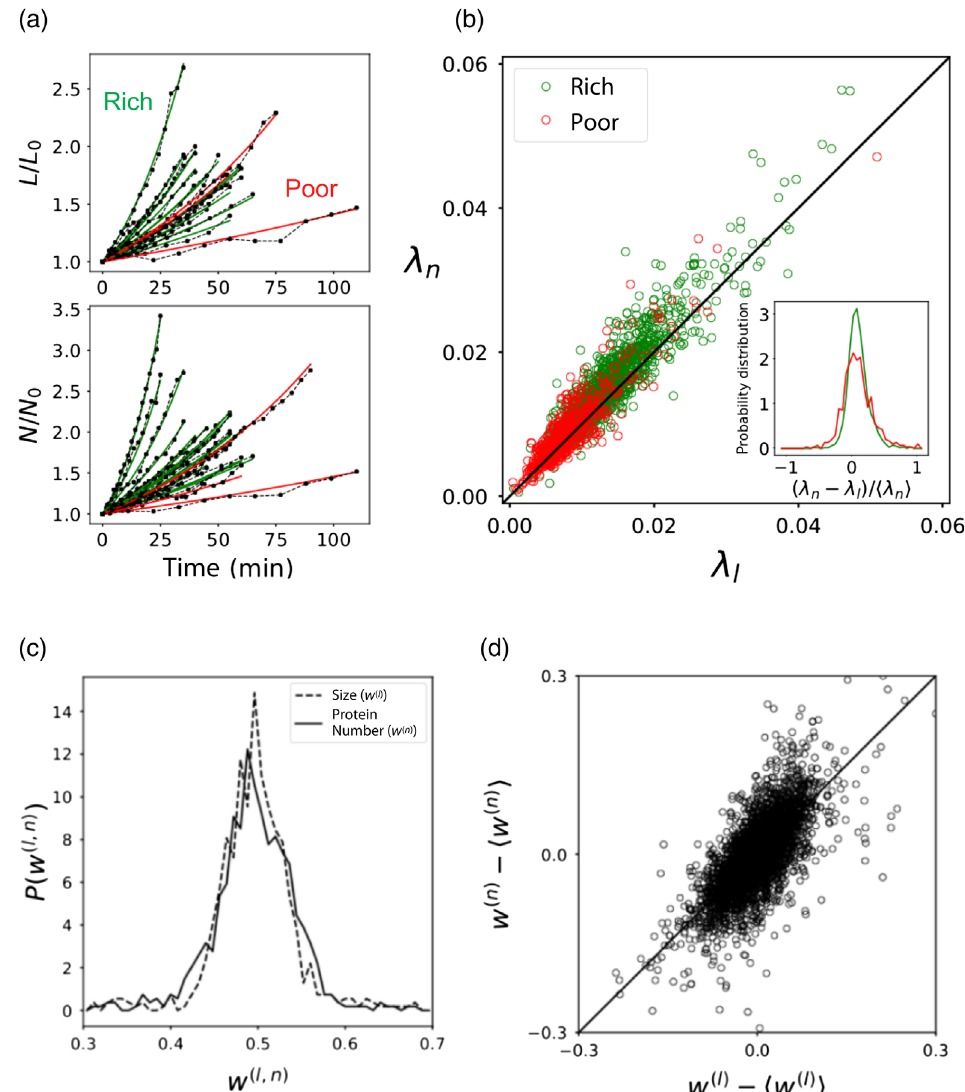
and λ are obtained by fitting the cell size and l n versus λ shows high l n and λ . (c) Distribution of the partition factors w ð l;n Þ for cell size and protein number. l n